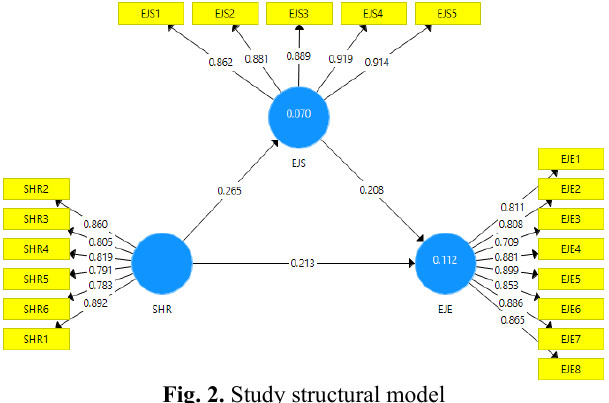
Fig. 2. Study structural